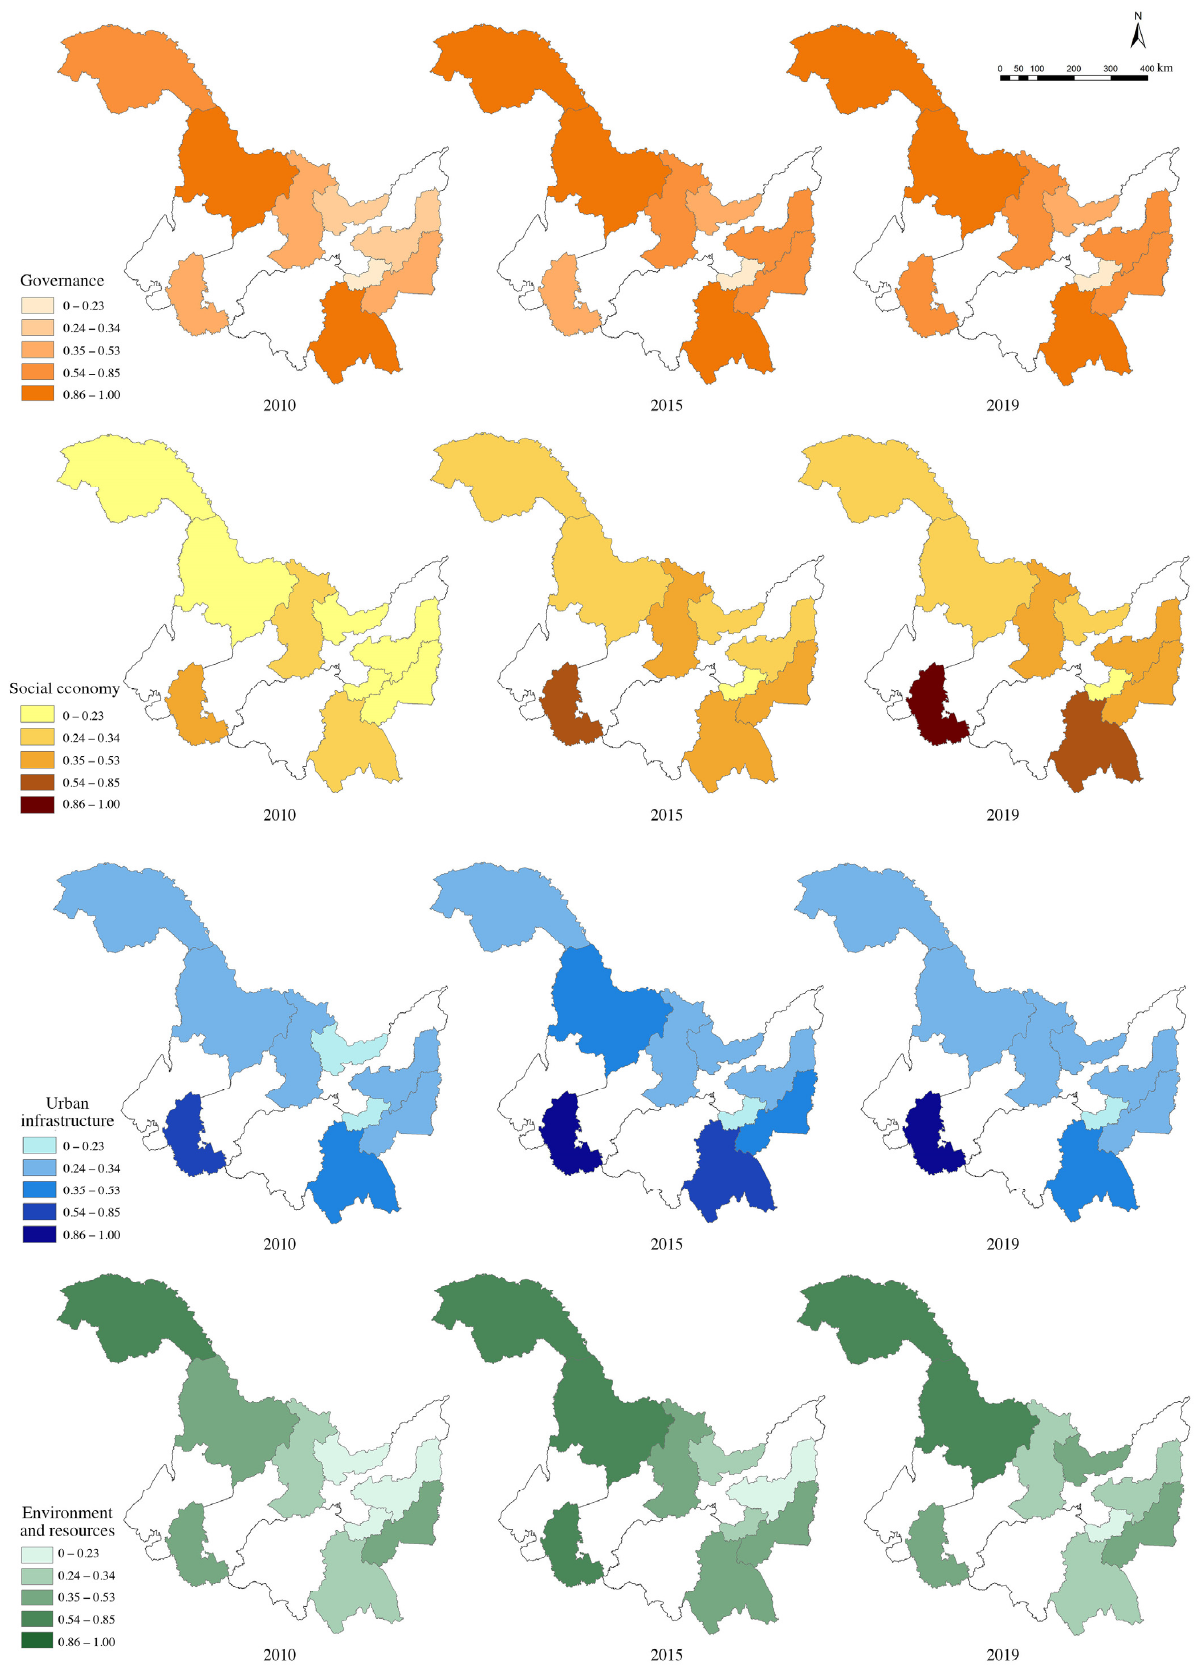
Figure 7. Spatial distribution of the resilience values in different dimensions of 9